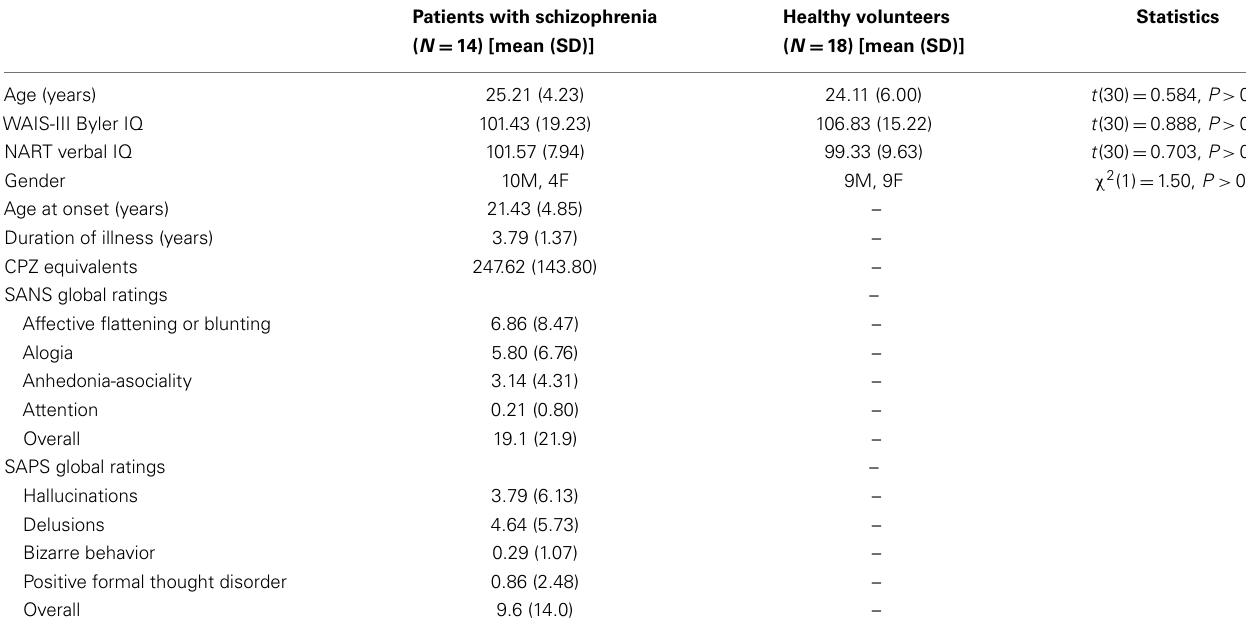
Table 1 | Demographic and clinical sample characteristics.